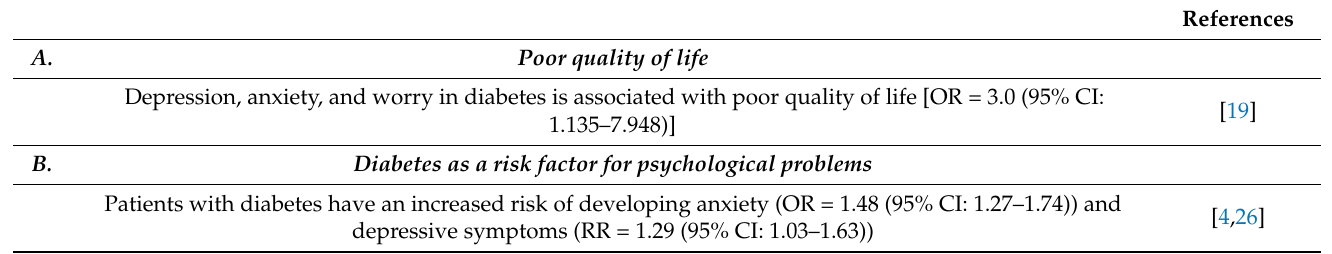
Table 1. Psychological background of patients with